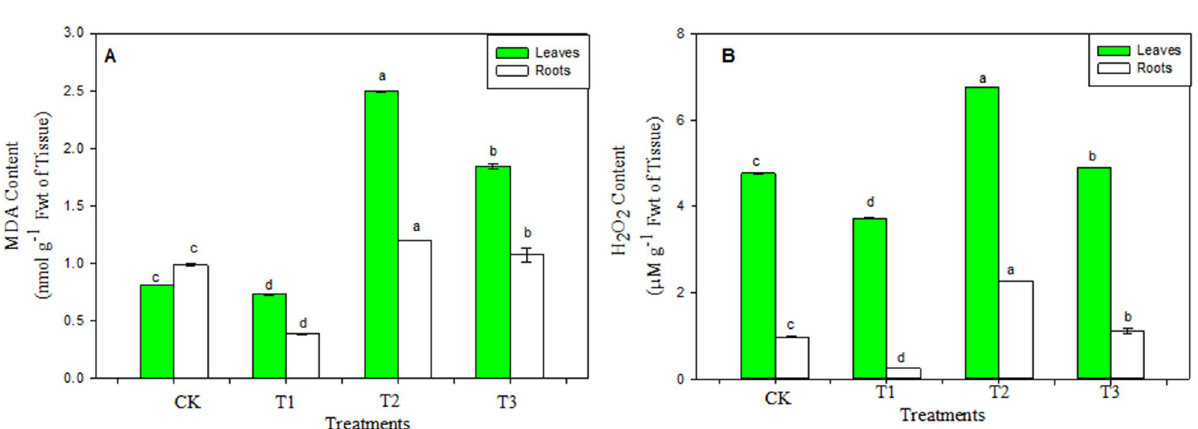
Figure 2. Effect of CdCl 2 (50 μM) alone or in combination with hemin (0.5 mM) on MDA (A) and H 2 O 2 (B) content in seedlings of Vigna radiata . CK, T1, T2 and T3 indicate control, 0.5 mM hemin, 50 μM CdCl 2 and 50 μM CdCl 2 + 0.5 mM hemin respectively. Values are mean ± SE (n = 3) and are statistically significant according to DMRT test (p < 0.05). Data points marked with the different letters show significant differences (p < 0.05) within